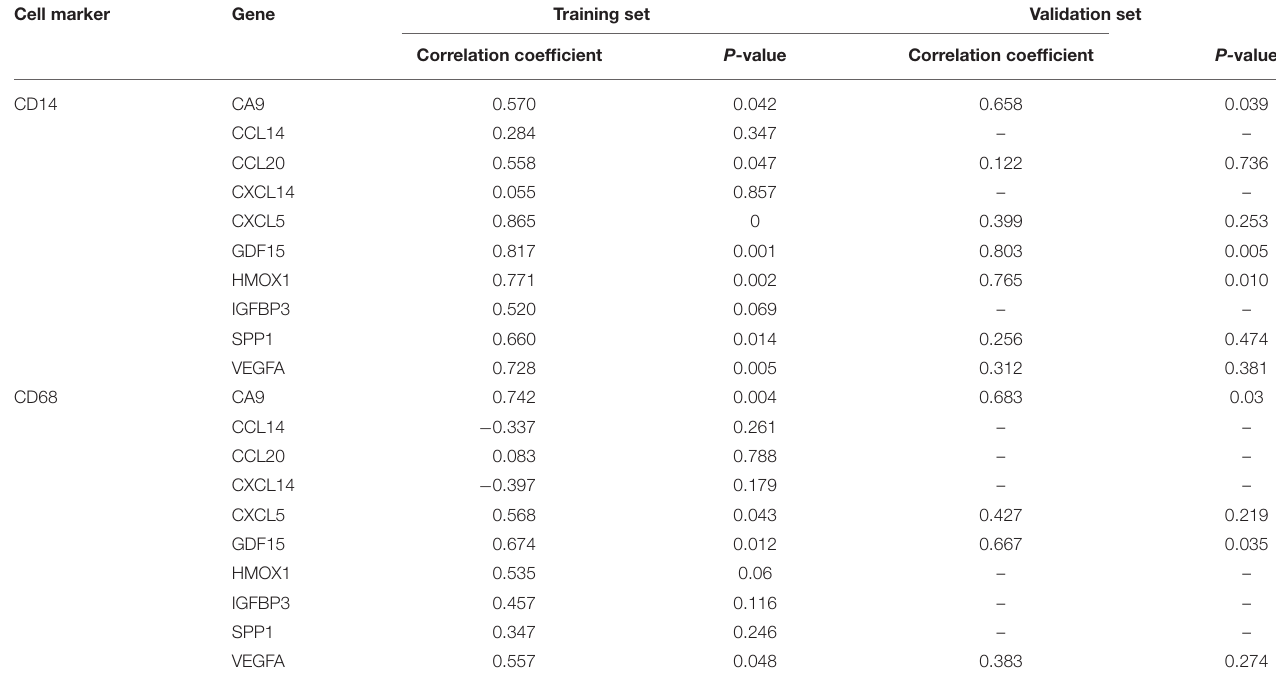
TABLE 2 | Correlation analysis between immune cell and hub genes in the training set and the validation set. Cell marker